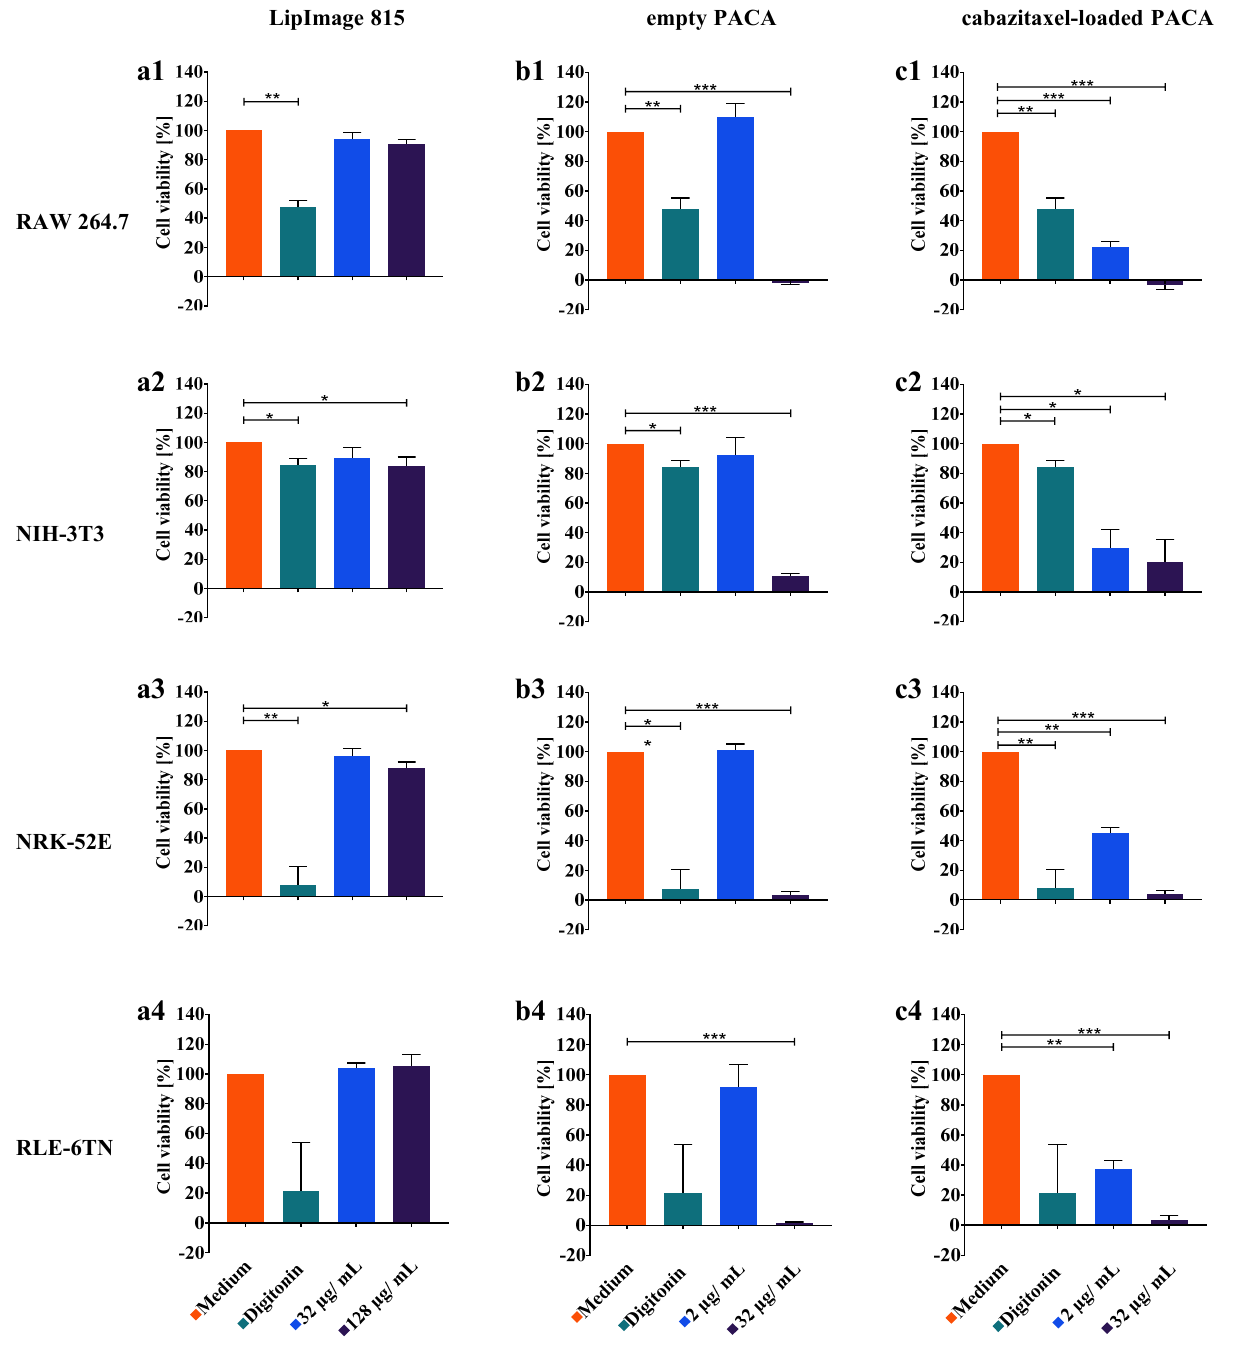
Figure 6. Cell viability of the four cell lines incubated with nanoparticles and controls measured by the colorimetric WST-8 assay. Cell culture and cell seeding procedures were performed in analogy to DHM QPI experiments, except for cabazitaxel-loaded PACA nanoparticles, where the concentration was increased to 32 µg/mL with respect to comparability to their empty counterpart (for further details, see text). Photometric readout of assay plates was performed 24 h after incubation of cells with controls and nanomaterials. Medium control served as a reference point for cell viability and was set to 100%. LipImage™ 815 lipidots® ( a1 – a4 ), empty PACA nanoparticles ( b1 – b4 ), and cabazitaxel-loaded PACA nanoparticles ( c1 – c4 ) were tested on the four selected cell lines. Plotted are mean values and standard deviations of 24 technical repeats ( n = 24) from three independent experiments ( N = 3). An ANOVA was performed for the statistical analysis of the WST-8 assay results, and significance levels were given as p < 0.005(***), p < 0.01(**), and p < 0.05(*).